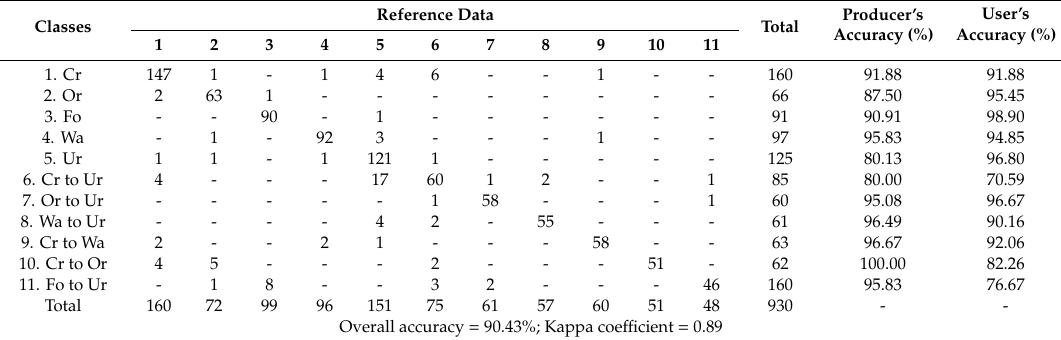
Table 7. Confusion matrix of the PCA-based method,